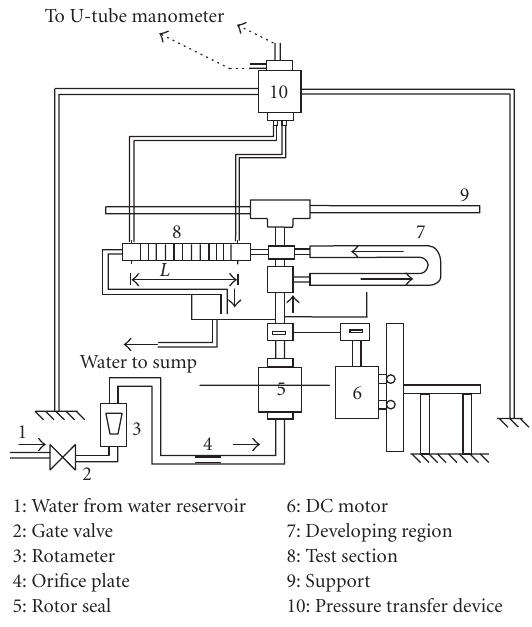
Figure 1: Experimental